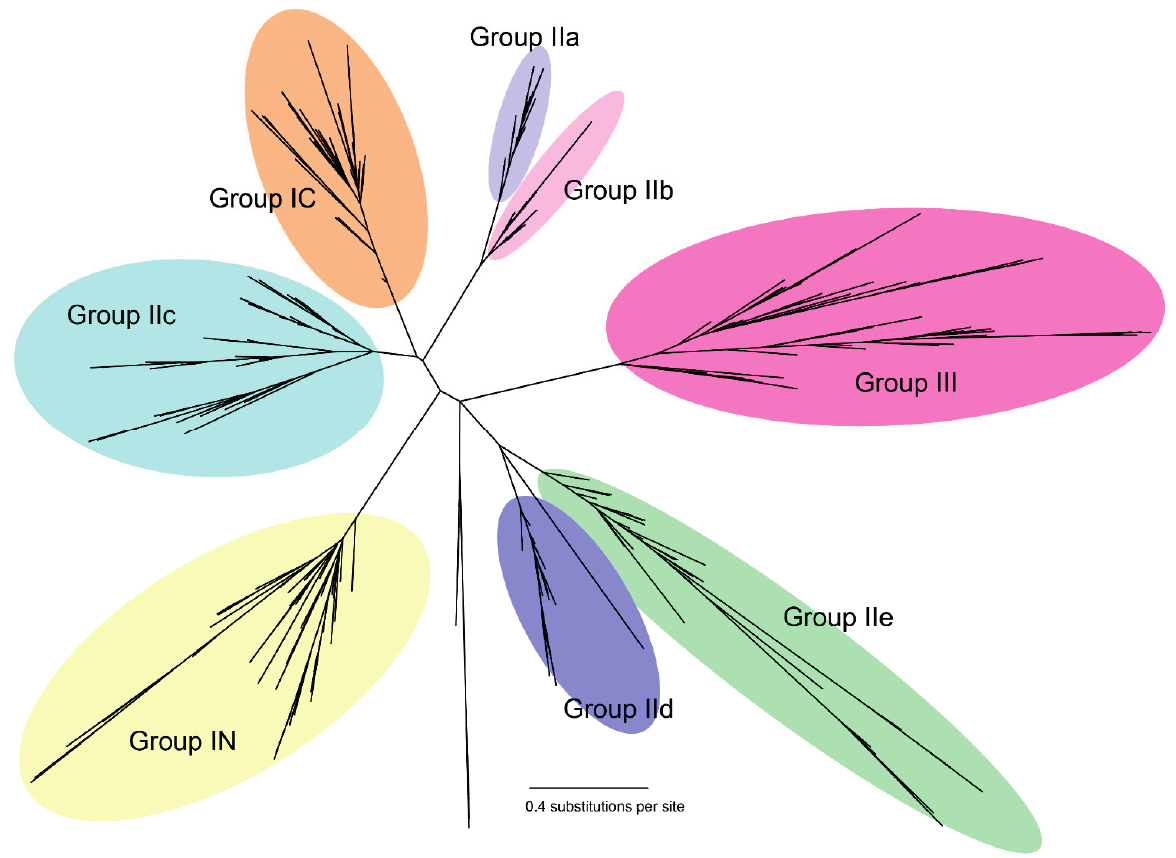
Figure 1. Phylogenetic tree of WRKY domains from ten species. The amino acid sequences of the WRKY domains were aligned, and the unrooted phylogenetic tree was constructed using the maximum likelihood method. The WRKY groups and subgroups are